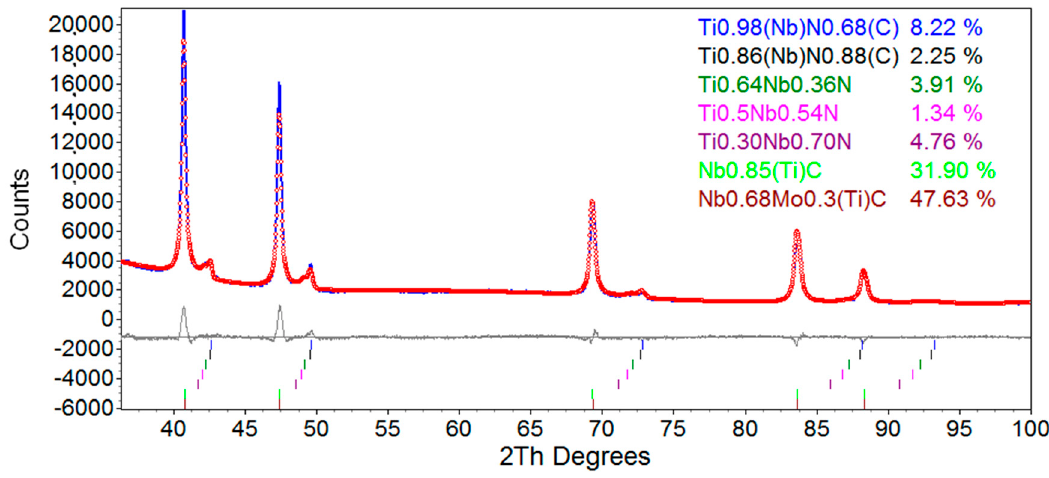
Figure 8. Comparison between measured and predicted diffraction patterns for X70 steel.